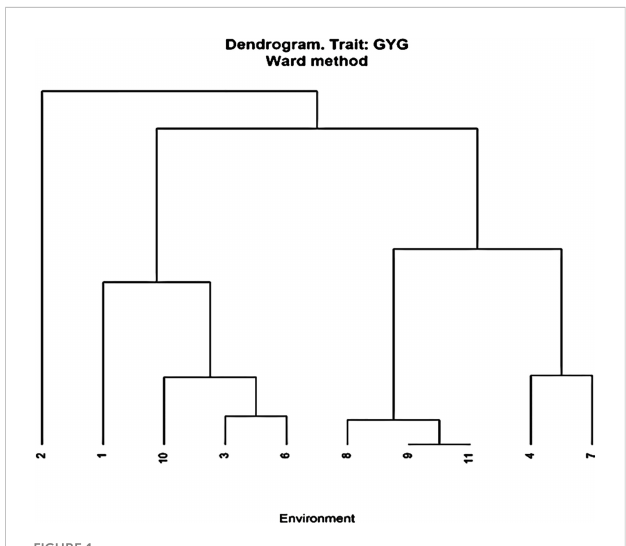
FIGURE 1 Cluster analysis of environments based on grain yield of 84 hybrids from 11 lines and seven testers and seven checks grown at 10 stress and non-stress environments in Zimbabwe. Optimum environments were 1 = ART Farm; 2 = CIMMYT; 4 = RARS; 7 = Gwebi. Managed LN environments were 3 = CIMMYT LN; 6 = DR&SS and combined heat and drought environments were 8 = Chiredzi; 10 = Chisumbanje. Well-watered environments were 9 = Chiredzi; 11 = Chisumbanje.